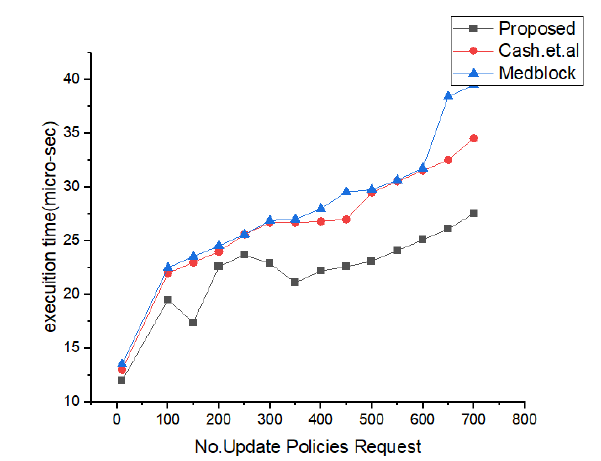
Figure 16. Experimental results for Proposed Method vs. benchmark Models .